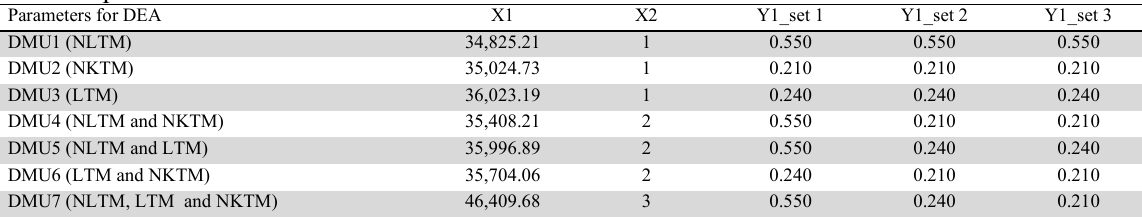
Relevant parameters for DEA Parameters for DEA